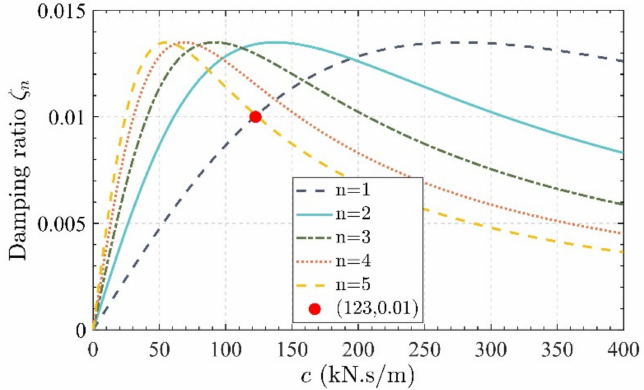
Figure 8. Damping curves of cable equipped with a viscous damper for damper